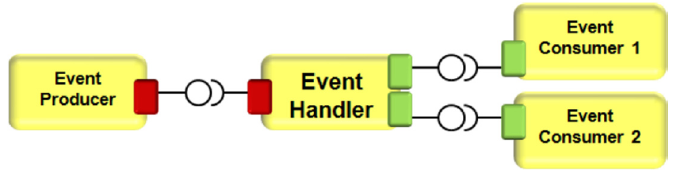
Figure 19. Event Handler system design [58].